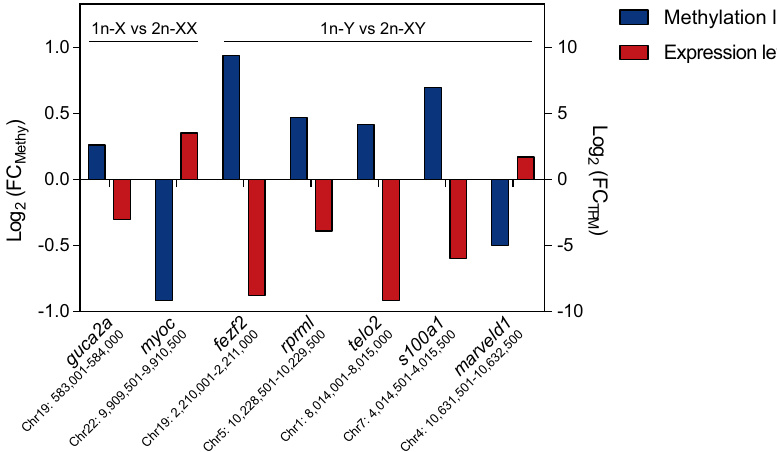
Figure 5. Correlation between methylation and expression levels of target genes. The left Y-axis represents log2 fold change of methylation level of DEGs between haploid and diploid tiger pufferfish, and the right Y-axis represents the log2 fold change of expression level (TPM) of corresponding DEGs between haploid and diploid tiger